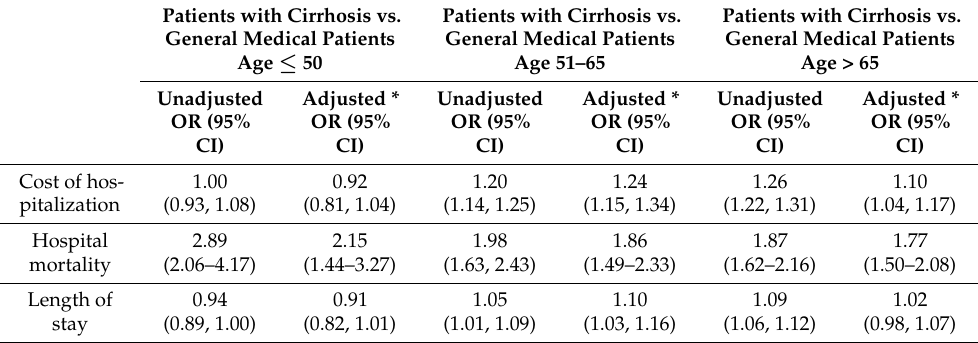
Table 3. Regression analysis for hospitalized general medical and patients with cirrhosis with muscle loss